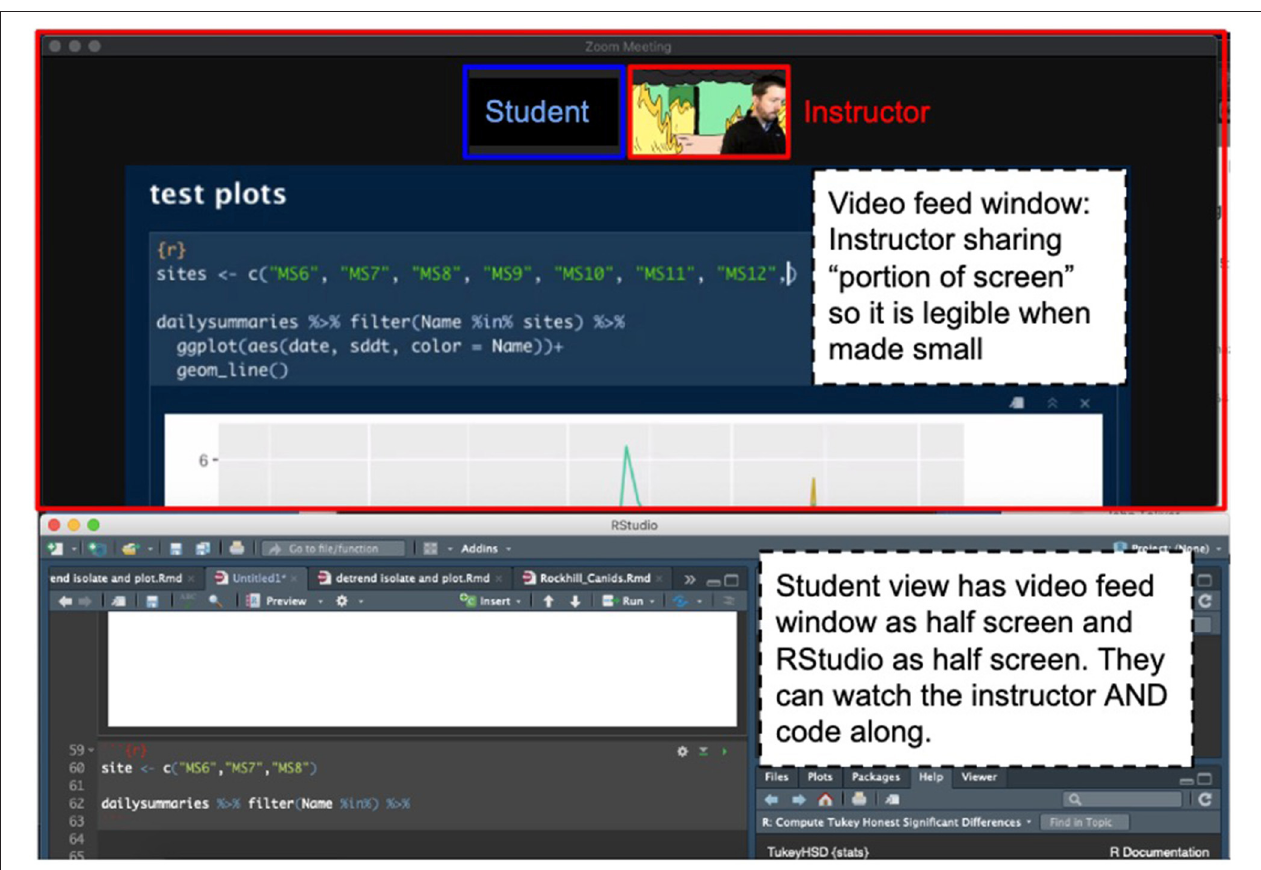
FIGURE 3 | In a virtual environment, encourage students to be mindful of how they set up their screen. In this figure, we show one setup that has worked well for the authors. The setup above shows an example of a student’s single screen. In it, the student has their zoom window sized to fit the top half of the screen and RStudio sized to the bottom half. With this setup, the student can watch and code at the same time. It is critical for this to work that the instructor only shares part of their screen, allowing them to show just their code, making it legible even when a small window on an already small screen. We recommend sharing an image such as this at the start of the semester, especially for students participating in a virtual or hybrid learning